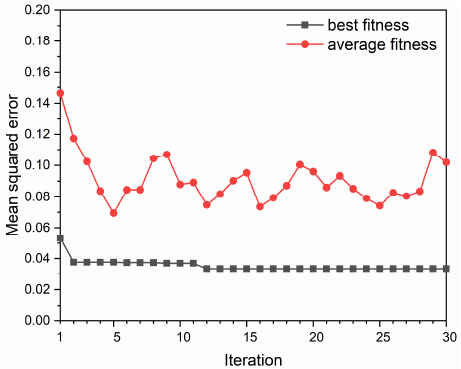
Figure 9. Fitness curves based on the categorized randomly segmented dataset.